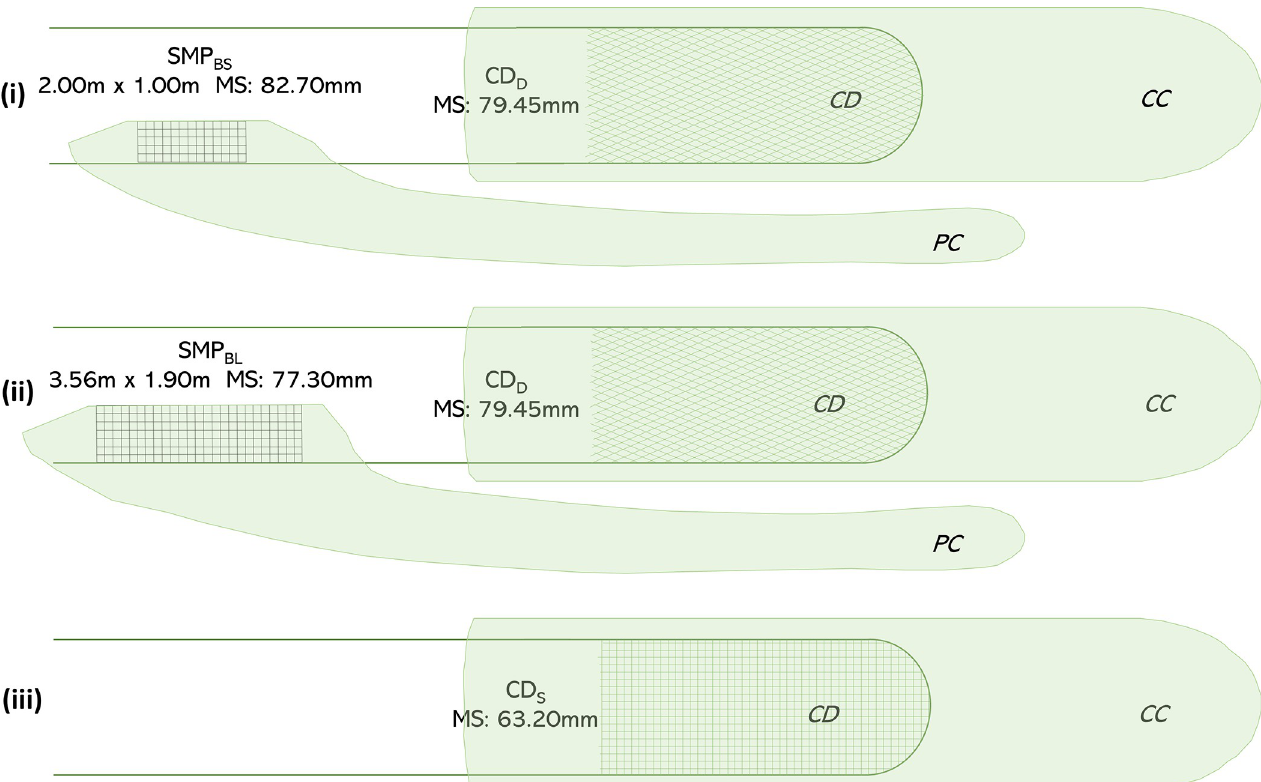
Fig 2. Experimentally tested gears with the covers used to collect fish. MS: mesh size.